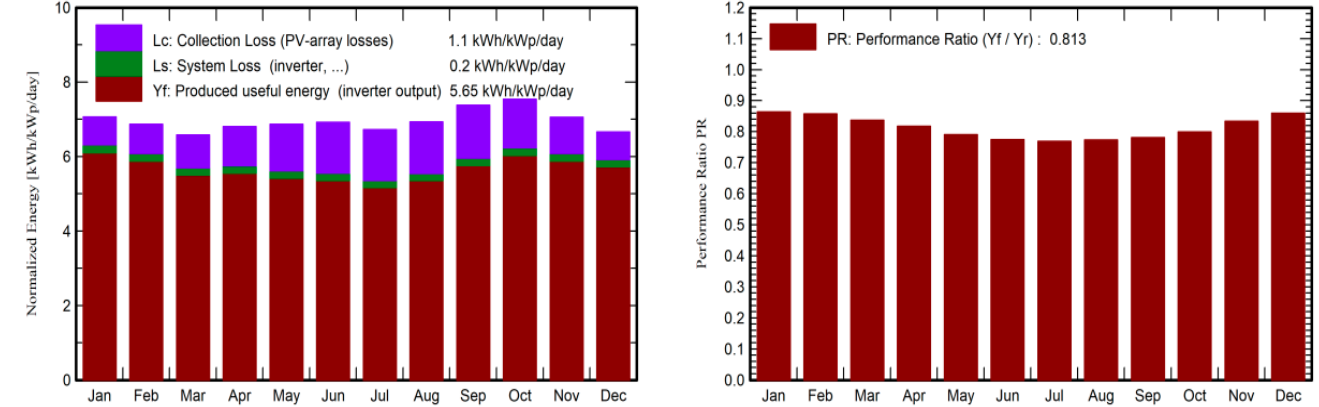
Figure 4. Normalized production and performance ratio for the Darab area.